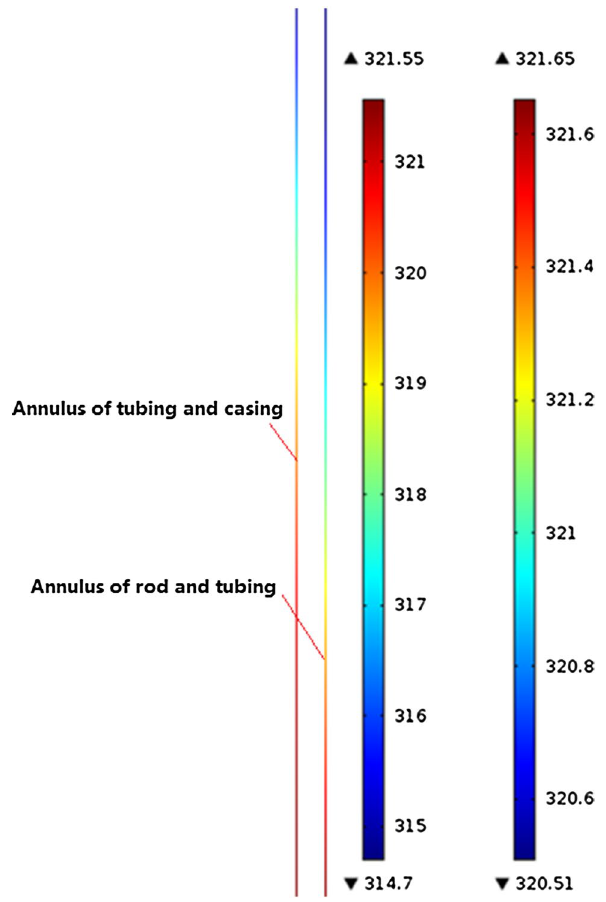
Fig. 4 Temperature field of center line of annulus of rod and tubing, tubing and